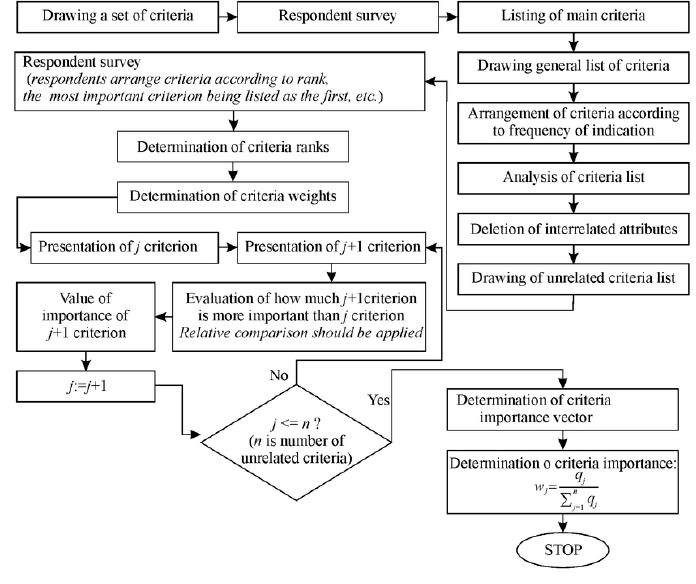
Figure 3. Flowchart of SWARA method [74].